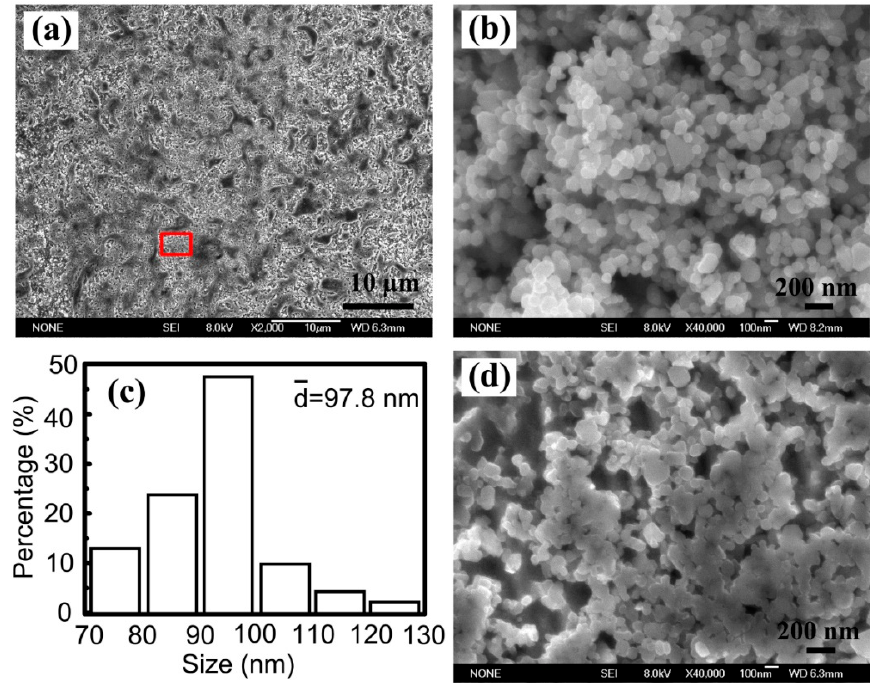
Figure 2. ( a ) Morphology of the deep etched surfaces of the master alloy, ( b ) the TiC p extracted from the TiC p /Cu master alloy, ( c ) size distribution of extracted TiC p and ( d ) enlarged image corresponding to selected area.